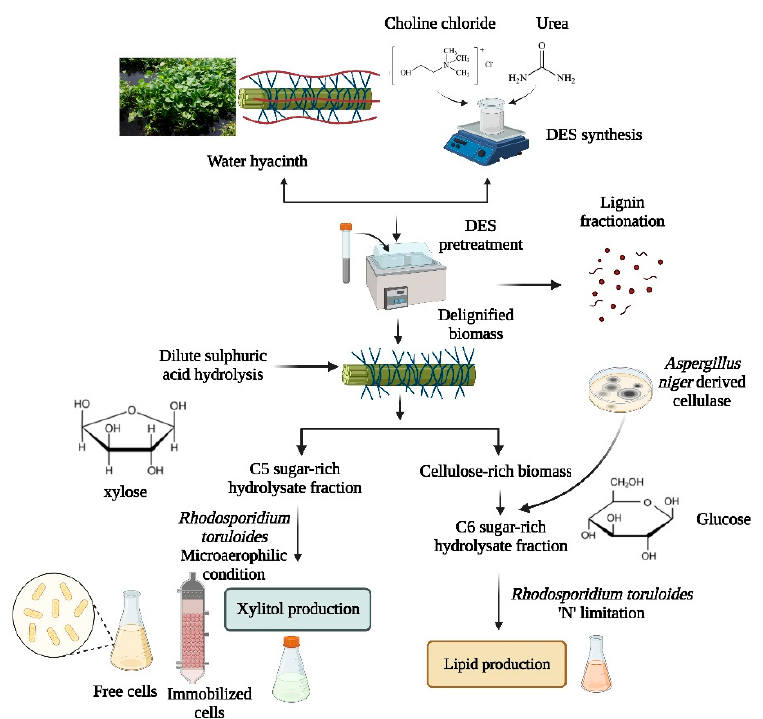
Figure 1. Flow of process adopted in the strategic utilization of cellulosic and hemicellulosic fractions of WH for xylitol and lipid synthesis using Rhodosporidium toruloides NCIM 3547 .